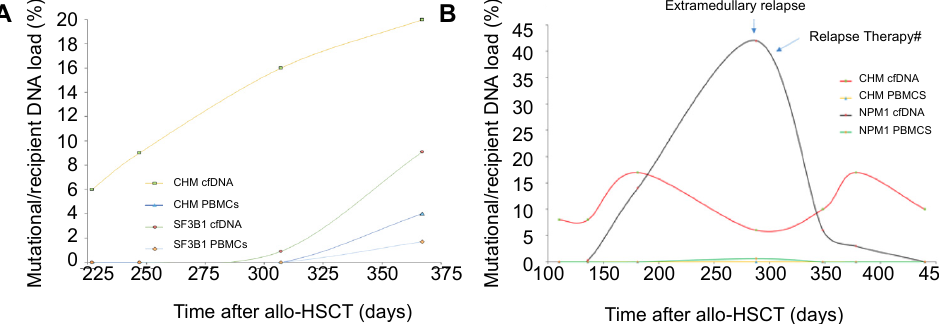
Figure 4. Kinetics of measurable residual disease in cfDNA and PBMCs. ( A ) Representative example of the MRD kinetics of hematological relapse kinetics in an AML patient after allo-HSCT. Increasing MC and MRD (MRD marker: SF3B1 R625C) could be detected earlier in cfDNA ( ● ■ ) when compared with PBMCs ( ▲♦ ). ( B ) In a patient with extramedullary relapse (breast), the MRD marker (NPM1) * increased ( ▲ ) and after relapse therapy, a decrease in MRD could be observed. In the same patient a fluctuating MC could be detected during this period ( ■ ). cfDNA, circulating-free DNA; PBMCs, peripheral blood mononuclear cells; MRD, measurable residual disease; MC, mixed chimerism; allo-HSCT, allogeneic hematopoietic stem cell transplantation. * NPM1 NCN was multiplied by 100 to fit the scale. #Relapse therapy included local radiation, decitabine and venetoclax.